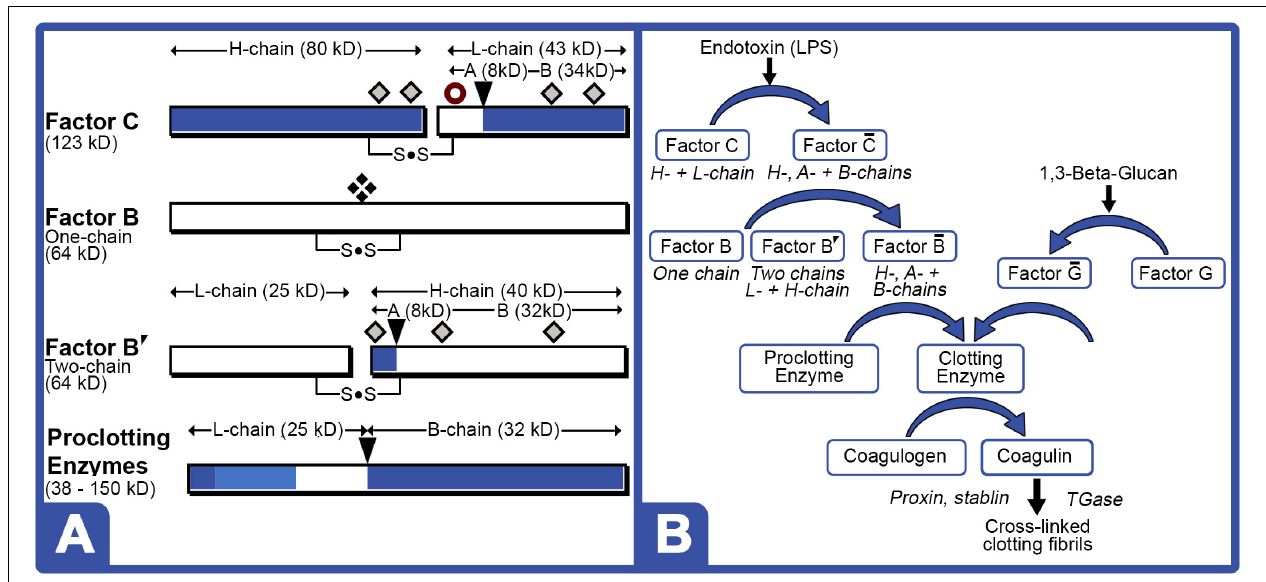
FIGURE 5 | LAL clotting factors structures and coagulation cascade. (A) Cleavage sites [  ] for activation; [  ] nicking site; [  ] potential glycosylation sites; and [  ] newly proposed phosphorylation site in the protein zymogen. Zymogen Factor B is a single-chain form; whereas, “nicked” double-chain form is composed of L- and H-chains, both containing internal disulfide bond. (B) Schematic of LPS and 1,3-Beta-Glucan LAL coagulation cascade. LPS converts phosphorylated or glycosylated Factor C zymogen (H- + L-chain subunits) into activated Factor C enzyme (A- + B-chain subunits). Activated Factor C nicks single-chain Factor B zymogen into Factor B (cid:48) (H-chain) glycosylated precursor that is converted to activated Factor B enzyme (B-chain). Activated Factor B and activated (1–3)- D -glucan binding factor G, initiate cleavage of various proclotting enzymes to form the clotting enzyme, which hydrolyzes coagulogen into coagulin, resulting in insoluble